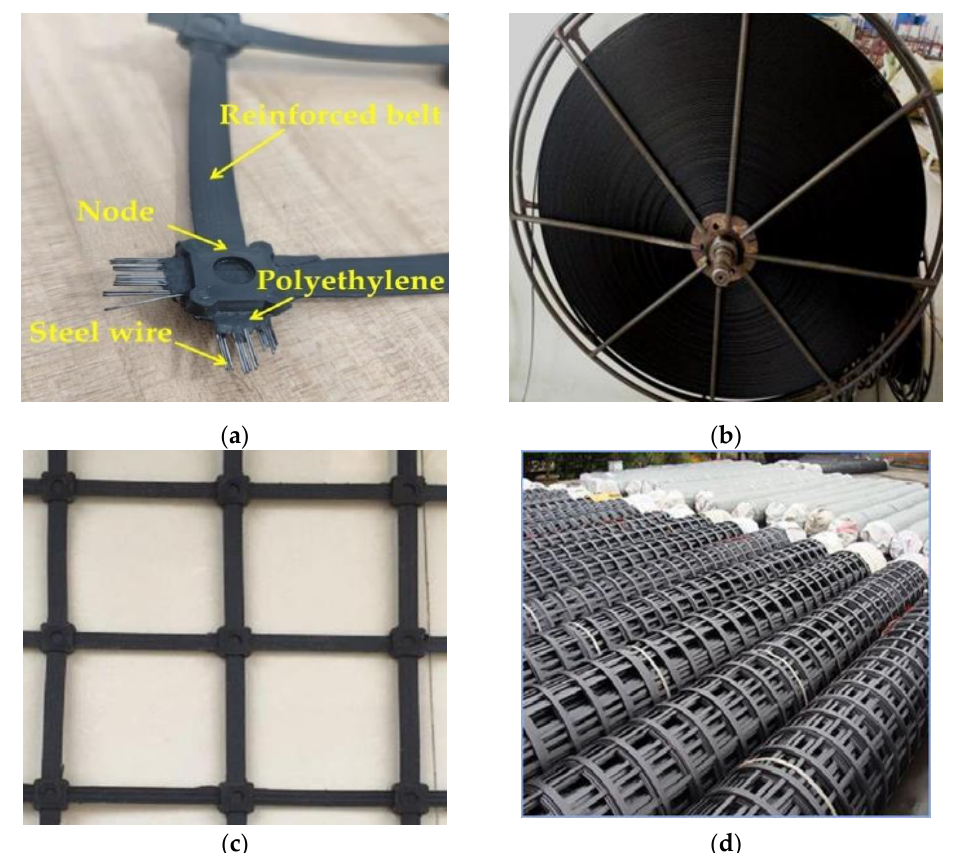
Figure 1. Steel-plastic geogrid structural structure and finished product display. ( a ) Steel-plastic geogrid ribbon construction; ( b ) finished steel-plastic geogrid reinforced belt; ( c ) steel-plastic geogrid mesh; ( d ) steel-plastic geogrid rolls.